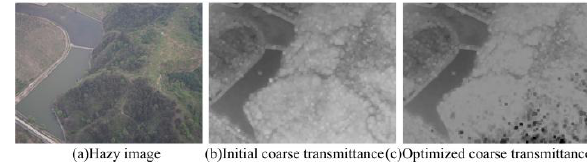
Figure 2. Transmission optimization comparison: (a) Hazy image. (b) Initial coarse transmittance. (c) Optimized coarse transmittance.